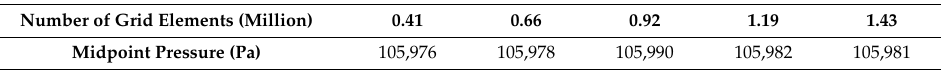
Table 1. Pressure value of the first arc starting position under di ff erent grid numbers.